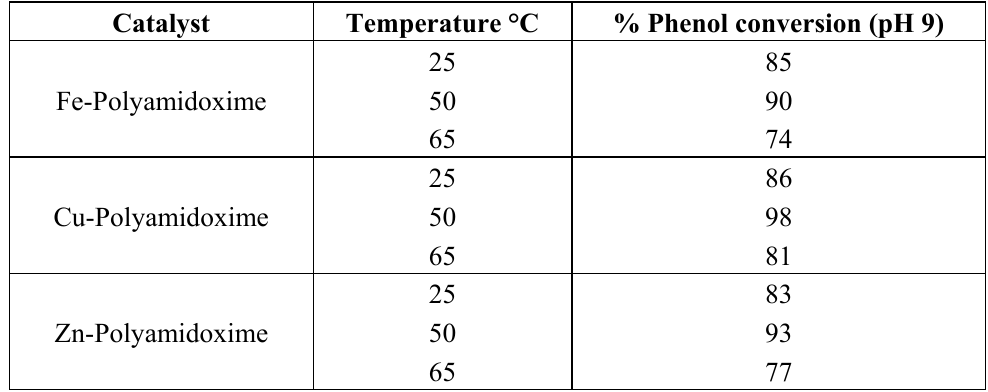
Table 4. Effect of